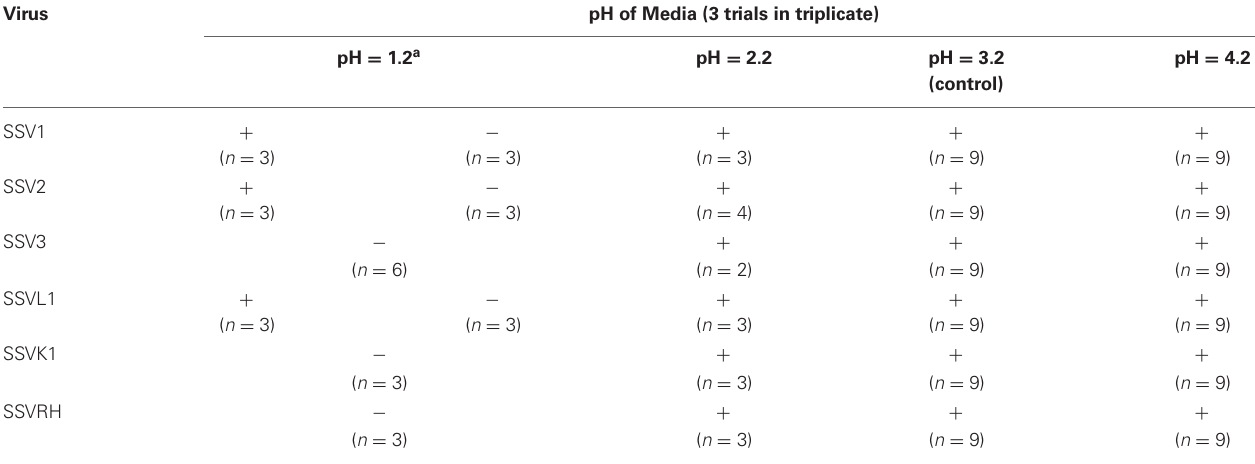
Table 2 | Halo formation on S. solfataricus G θ Lawns at differing pH values.